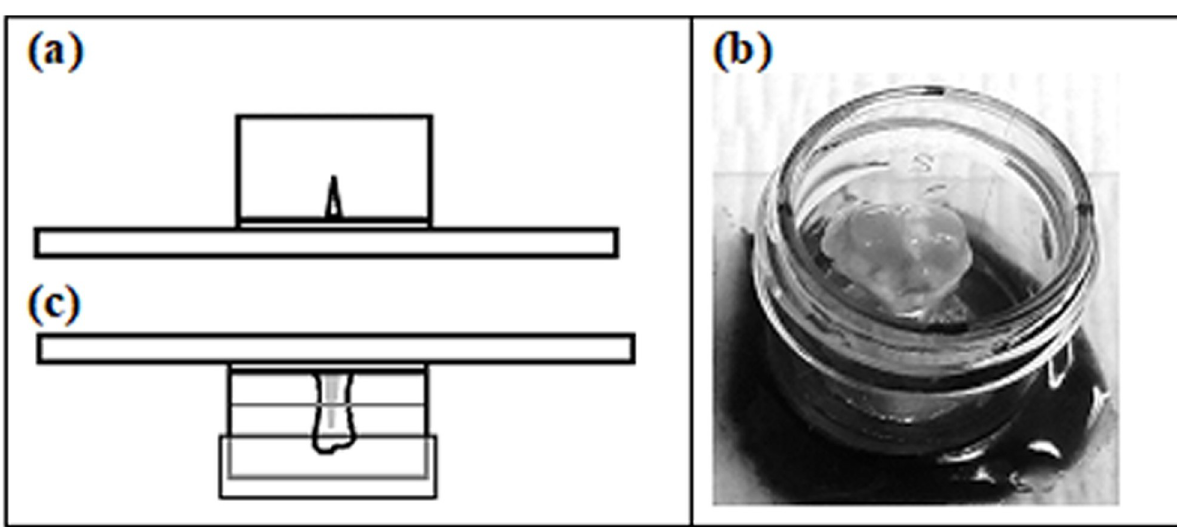
Fig 1. (A-C). Mounted tibial cartilage: (A) test-tube and earring back or thumbtack on microscope slide, (B) photograph of mounted tibia, (C) PBS emersion and mount inversion for